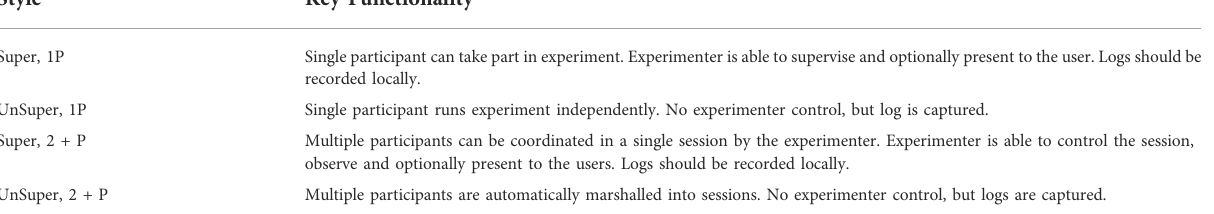
TABLE 1 Key functionality for different experimental types in distributed and remote MR experiments. 1P refers to single participant, and 2 + P to multi-participant.